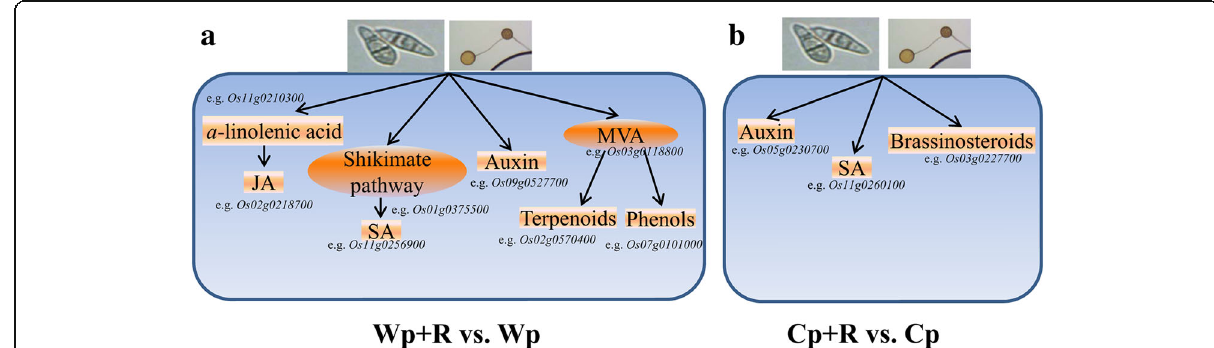
Fig. 8 Diagrammatic model of the responses of Rhizoglomus intraradices -uninoculated and R. intraradices -inoculated wild ( a ) and cultivated ( b ) rice to Magnaporthe oryzae infection. Cp + R, R. intraradices -inoculated cultivated rice infected with M. oryzae ; Cp, R. intraradices -uninoculated cultivated rice infected with M. oryzae ; Wp + R, R. intraradices -inoculated wild rice infected with M. oryzae ; Wp, R. intraradices -uninoculated wild rice infected with M. oryzae . SA, salicylic acid; JA, jasmonic acid; MVA, mevalonate Additional files